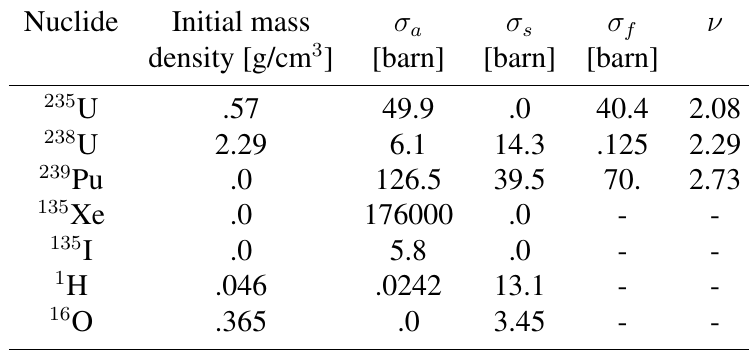
Table 1: Initial nuclide composition of all materials and group